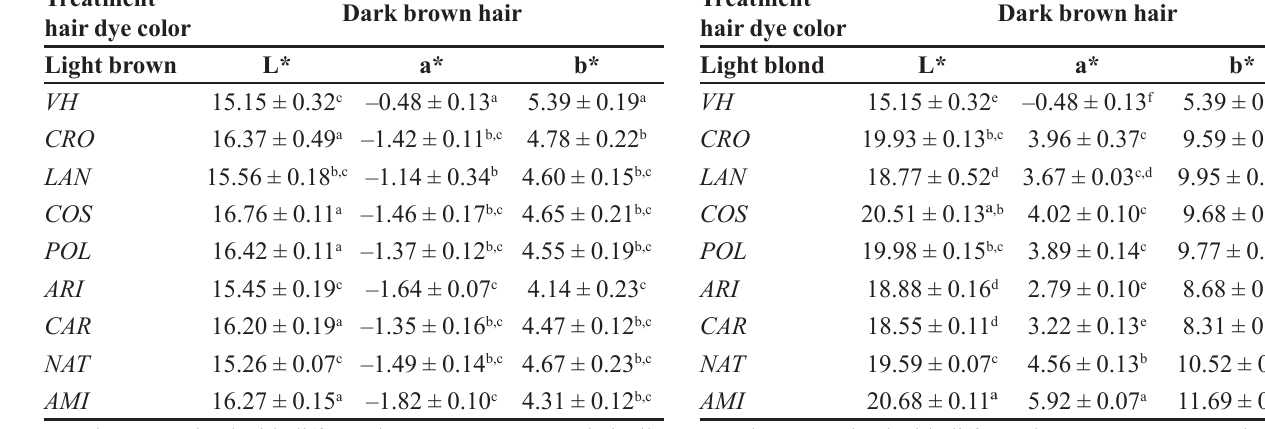
FIGURE 4 - Breaking strength for Caucasian light blond virgin hair and samples treated with light blond oxidative hair dyes. Results categorized with equal symbols (*) didn’t present as statistically and significantly different, for α = 5, p < 0.05, n = 5. VH: Virgin Hair; CRO: Cetearyl Alcohol (and) Dicetyl Phosphate (and) Ceteth-10 Phosphate/ Crodafos TM CES; LAN: Cetearyl Alcohol (and) Sodium Lauryl Sulfate (and) Sodium Cetearyl Sulfate /Lanette N TM ; COS: Cetearyl Alcohol (and) Ceteareth-20/ Cosmowax J TM ; POL: Cetearyl Alcohol (and) Polysorbate 60/ Polawax NF TM ; ARI: Ammonium Acryloyldimethyltaurate (and) VP Copolymer/ Aristoflex avc TM ; CAR: Carbomer/ Carbopol TM 980 ; NAT: Hydroxyethylcellulose/ Natrosol TM HHR ; AMI: Sclerotium gum/ Amigel TM . TABLE III - Color and Brightness parameter for Caucasian dark TABLE IV - Color and Brightness parameter for Caucasian dark brown virgin hair and samples treated with light brown oxidative brown virgin hair and samples treated with light blond hair dyes Treatment